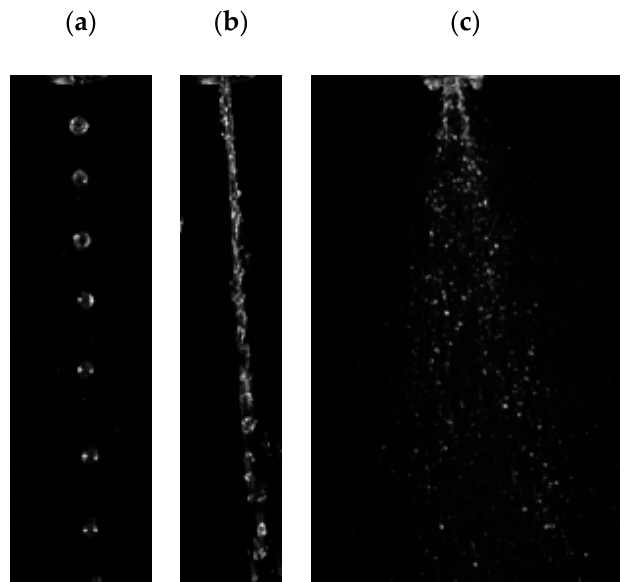
Figure 8. Selected structures of the sprayed liquid observed as a result of spraying water with an effervescent-swirl atomizer [7]: ( a ) 𝑀(cid:4662) (cid:3030) = 0,0014 kg/s, C5, ( b ) 𝑀(cid:4662) (cid:3030) = 0,021 kg/s, C5, ( c ) 𝑀(cid:4662) (cid:3030) = 0,008 kg/s, ( d ) 𝑀(cid:4662) (cid:3034) = 0,000014 kg/s, P. During the flow of 59% aqueous glycerin solution with the addition of 0.5% rocrysol WF1 in the effervescent-swirl atomizer, turbulences were observed on the surface of the stream due to swirling of the liquid stream (Figure 9d) [7]. The presented photos show the characteristic beads-on-a-string structure (BOAS) of a stream, i.e., thin threads of the sprayed liquid interconnecting the droplets (droplet-fibrous form of a stream) (Figure 9b). When spraying liquids with significant viscosities, the spray angle is reduced until a stream with large fibers and droplets is formed (Figure 9e). However, the appearance of turbulent flow, as a result of the increase in Reynold’s number, contributes to the destruction of the liquid structure and the reduction of the liquid viscosity, which results from the properties characteristic of non-Newtonian liquid properties [7]. Figure 9. Selected structures of the sprayed liquid observed during one- and two-phase spraying of a 59% water solution of glycerin with the addition of 0.5% rocrysol WF1 with the use of an effervescent-swirl atomizer [7]: ( a ) 𝑀(cid:4662) (cid:3030) = 0,0056 kg/s, C5, ( b ) 𝑀(cid:4662) (cid:3030) = 0,011 kg/s, 𝑀(cid:4662) (cid:3034) = 0,000028 kg/s, P, ( c ) 𝑀(cid:4662) (cid:3030) = 0,0056 kg/s, 𝑀(cid:4662) (cid:3034) = 0,000014 kg/s, LC, ( d ) 𝑀(cid:4662) (cid:3030) = 0,028 kg/s, LC, ( e ) 𝑀(cid:4662) (cid:3030) = 0,021 kg/s, LC, ( f ) 𝑀(cid:4662) (cid:3030) = 0,0028 kg/s, 𝑀(cid:4662) (cid:3034) = 0,00028 kg/s, P.